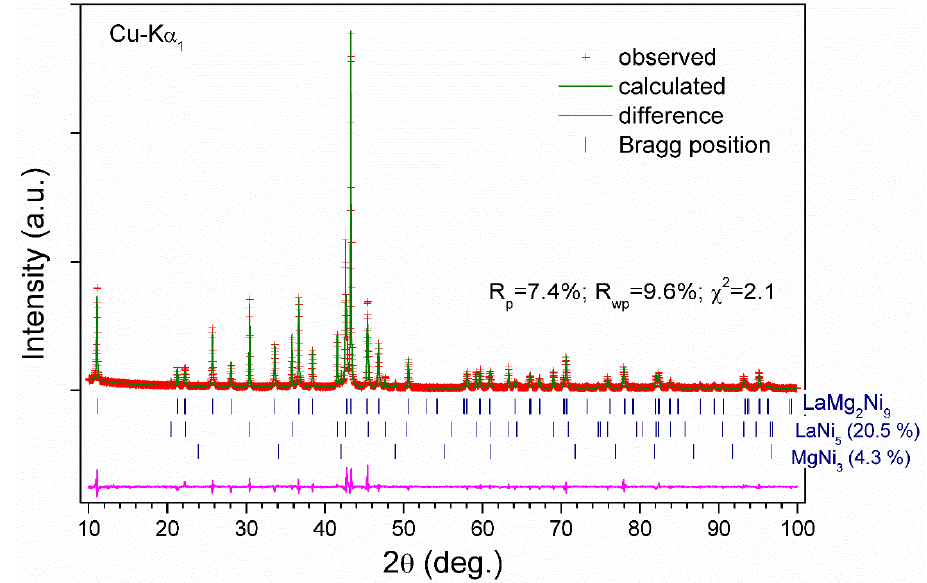
Figure 1. XRD pattern of La 0.91 Mg 2.09 Ni 9 (sample 2) (Cu-K α 1